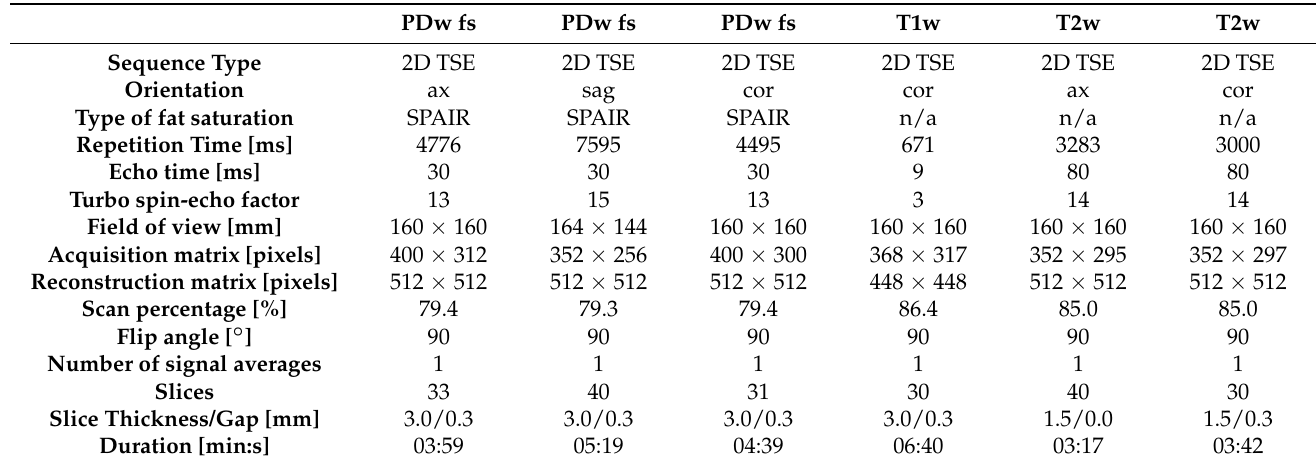
Table 1. Acquisition Parameters of the MRI sequences.